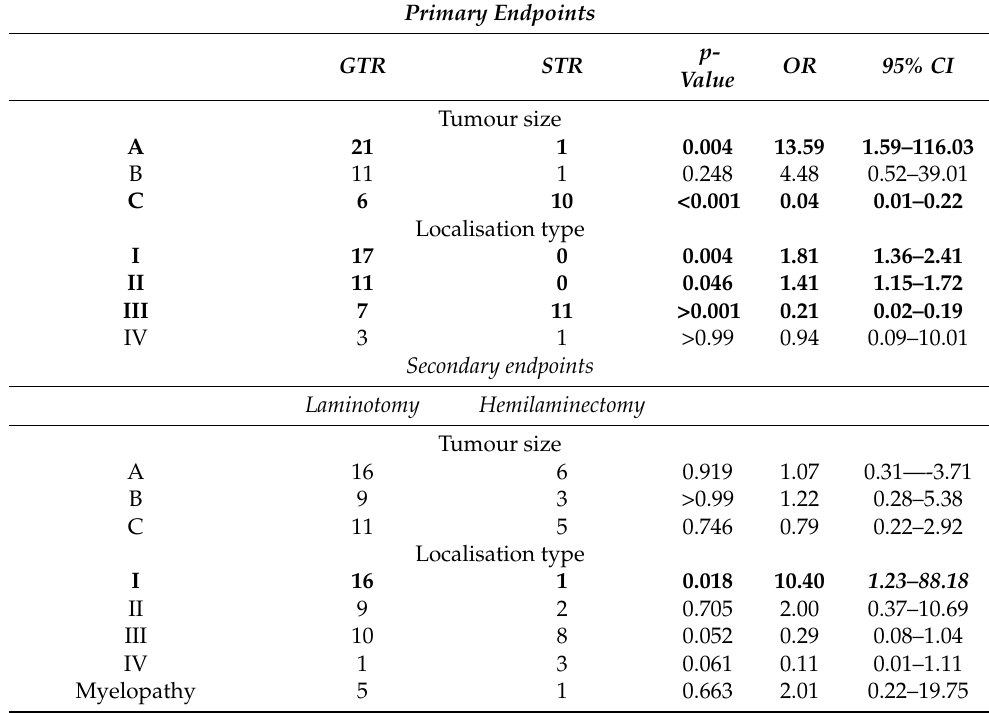
Table 2. Univariate